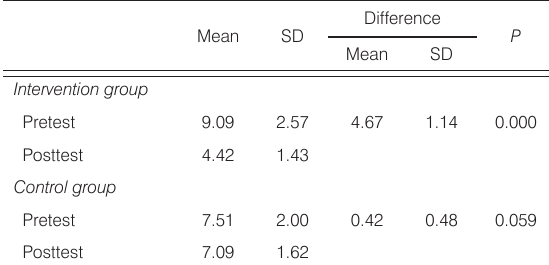
Table 4. The effect of hydrotherapy on sleep quality in the intervention and control groups (pre–post test design) ( n